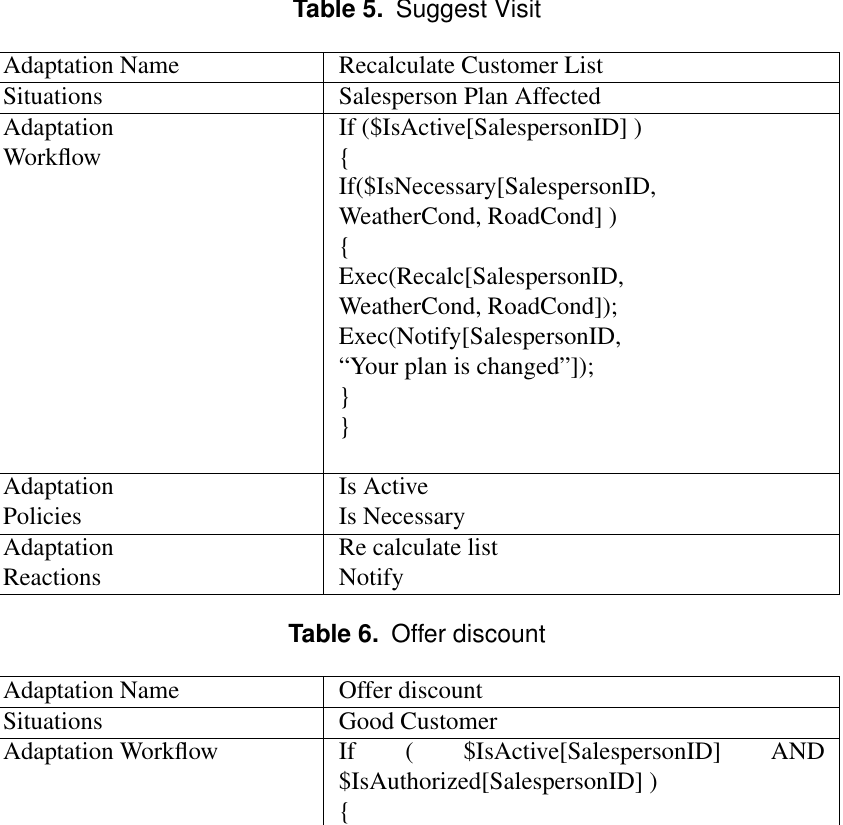
Table 4. Recalculate Customer List Table 5. Suggest Visit